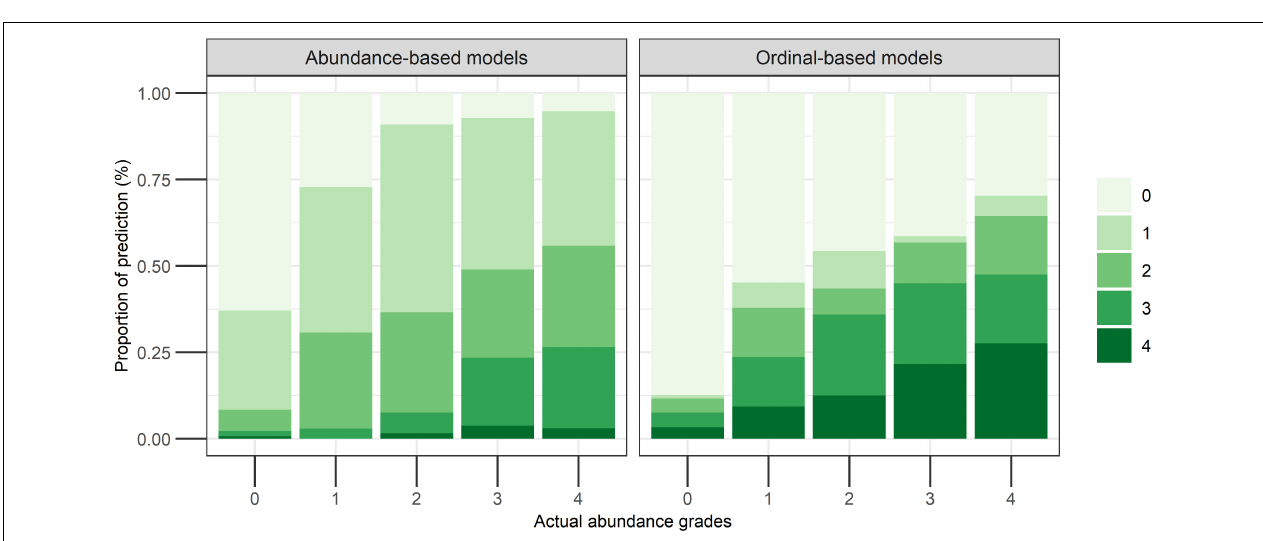
FIGURE 3 | The accuracy metric (AUC) of models trained with three data types for 9 demersal species in terms of predicting occurrence.